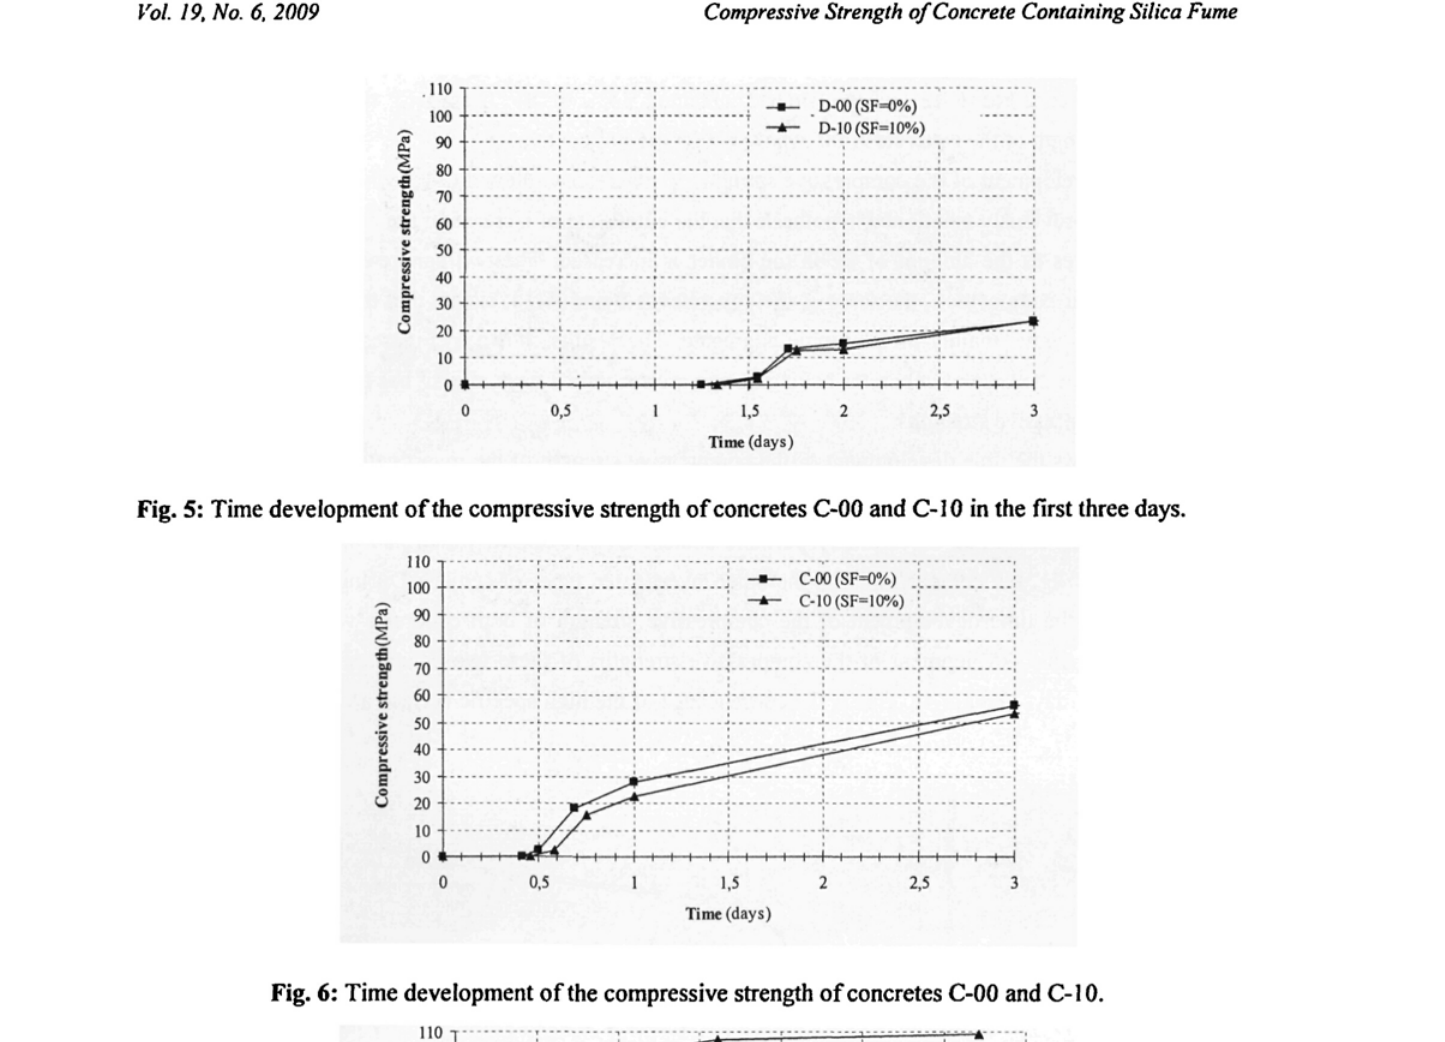
Fig. 6: Time development of the compressive strength of concretes C-00 and C-10.